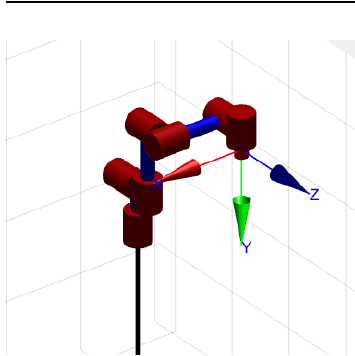
Figure 4. The manipulator sketch